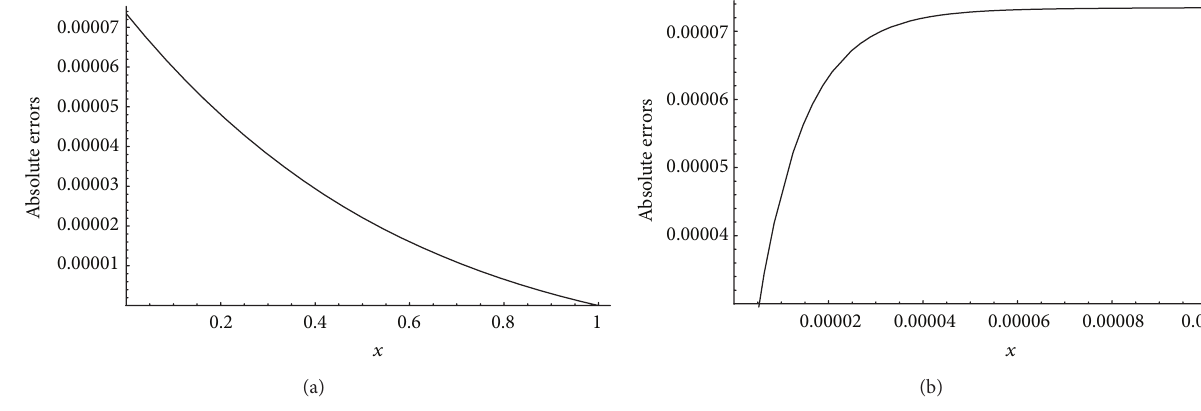
Figure 2: Absolute errors |𝑢(𝑥) − 𝑢 200 (𝑥)| of Example 1 for 𝜀 = 10 −5 ((a): regular domain; (b): boundary later domain).